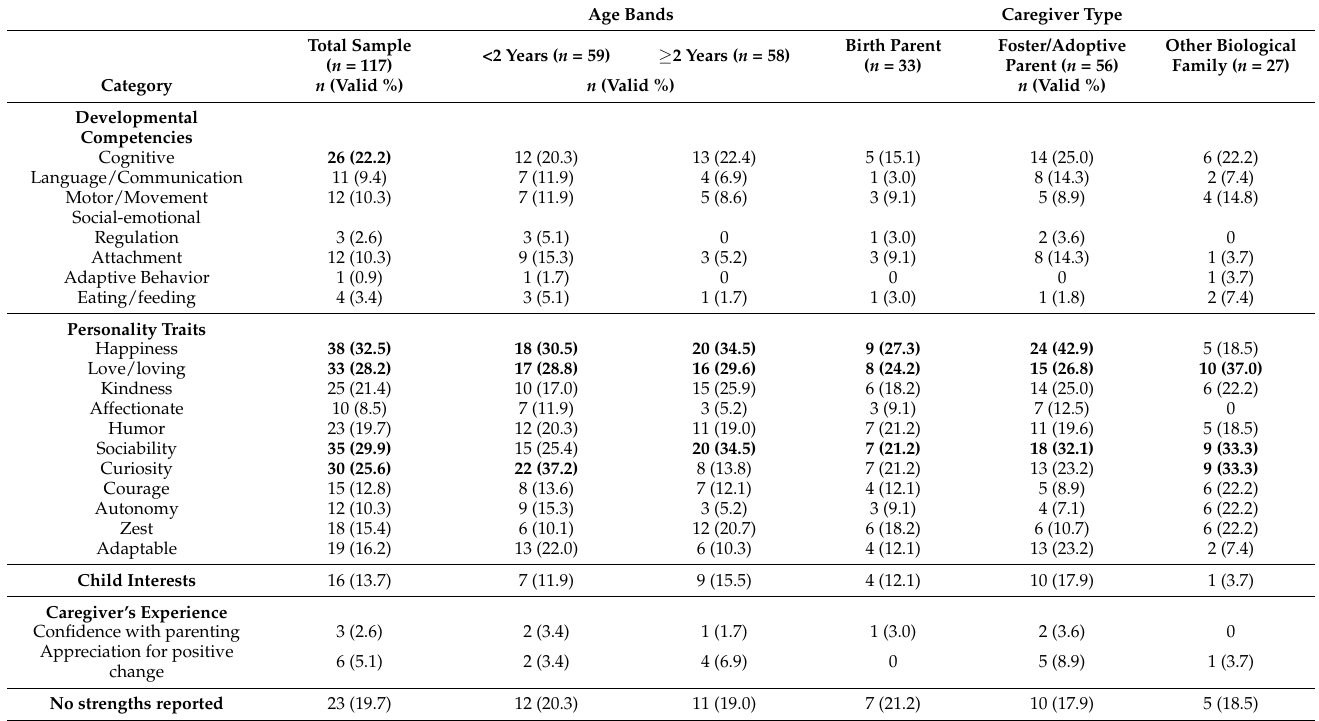
Table 3. Prevalence of reported strengths or best